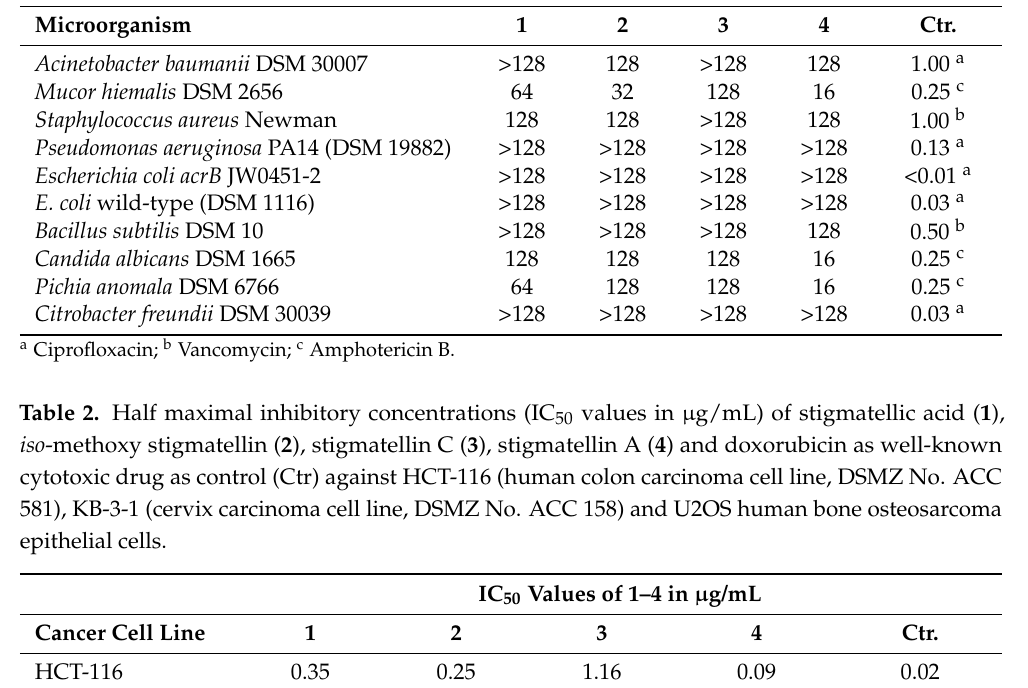
Table 1. Minimum inhibitory concentration (MIC) values ( µ g/mL) of stigmatellic acid ( 1 ), iso -methoxy stigmatellin ( 2 ), stigmatellin C, stigmatellin A ( 4 ) and different well-known antimicrobial drugs as control (Ctr) against common microbial pathogens. MIC Values of 1–4 in µ g/mL